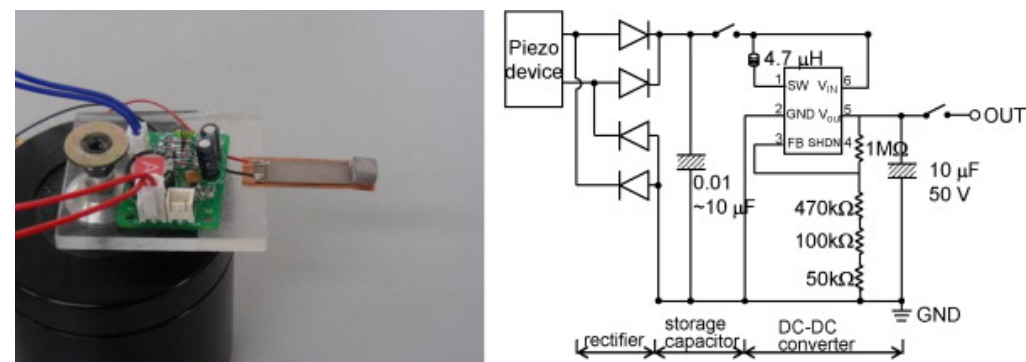
Figure 5. Two-layered piezoelectric bender device for micropower generation. The figure is from Jeong et al . [89] and is reprinted with permission from